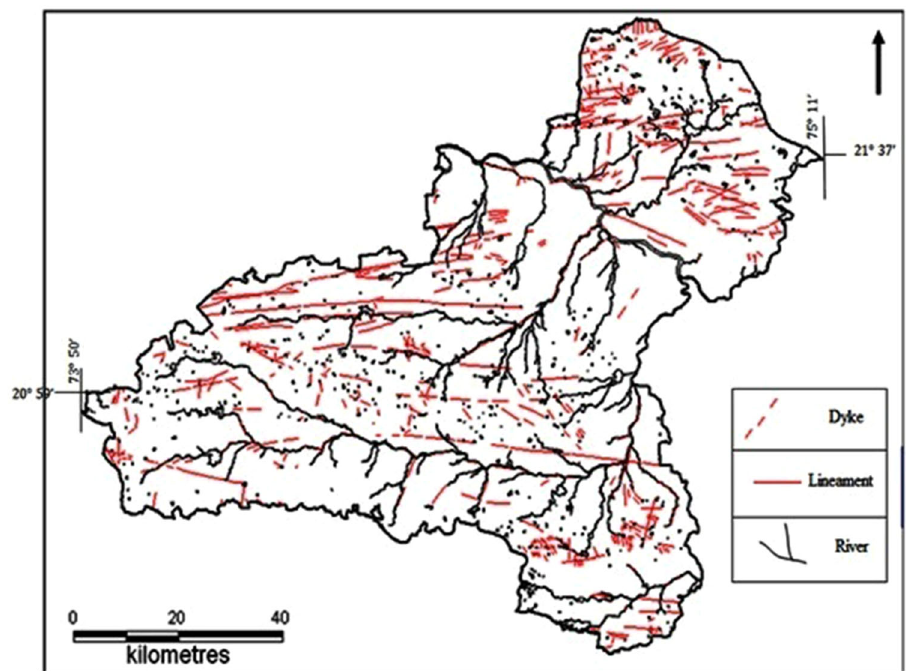
Fig. 2 Map showing